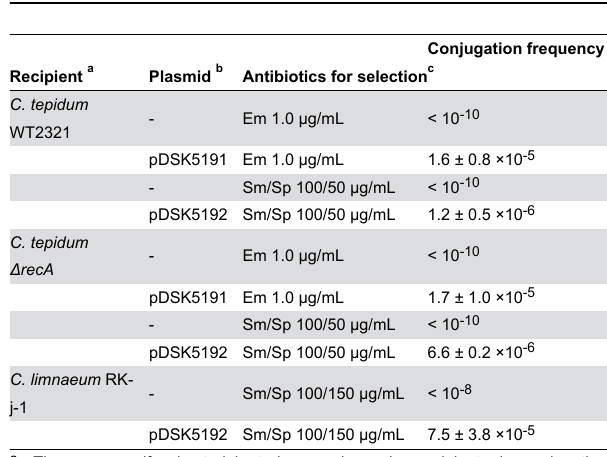
Table 3. Conjugation frequencies of C. tepidum and C. limnaeum with E. coli